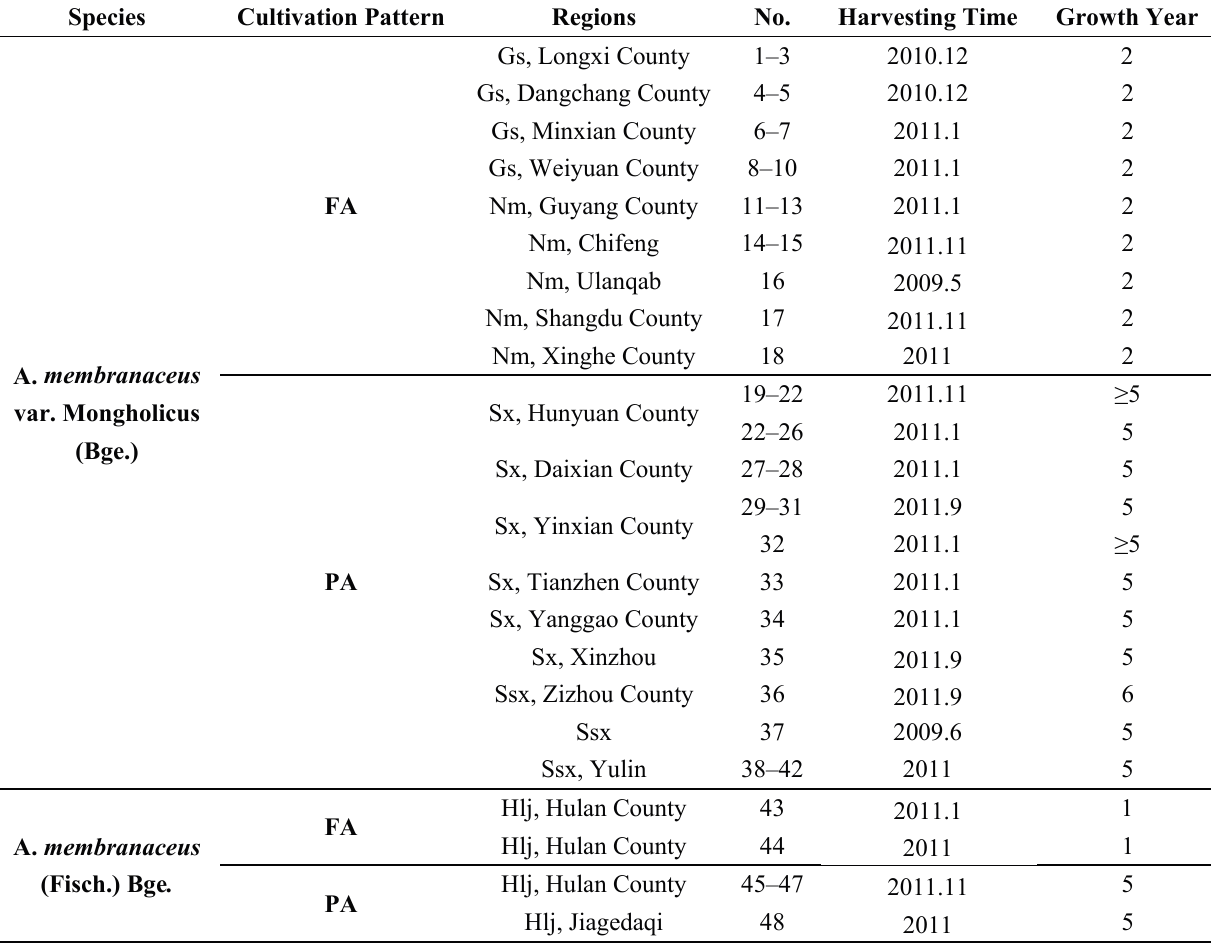
table (SHK-99-II type, Beijing North TZ-Biotech Develop, Co., Ltd. Beijing,